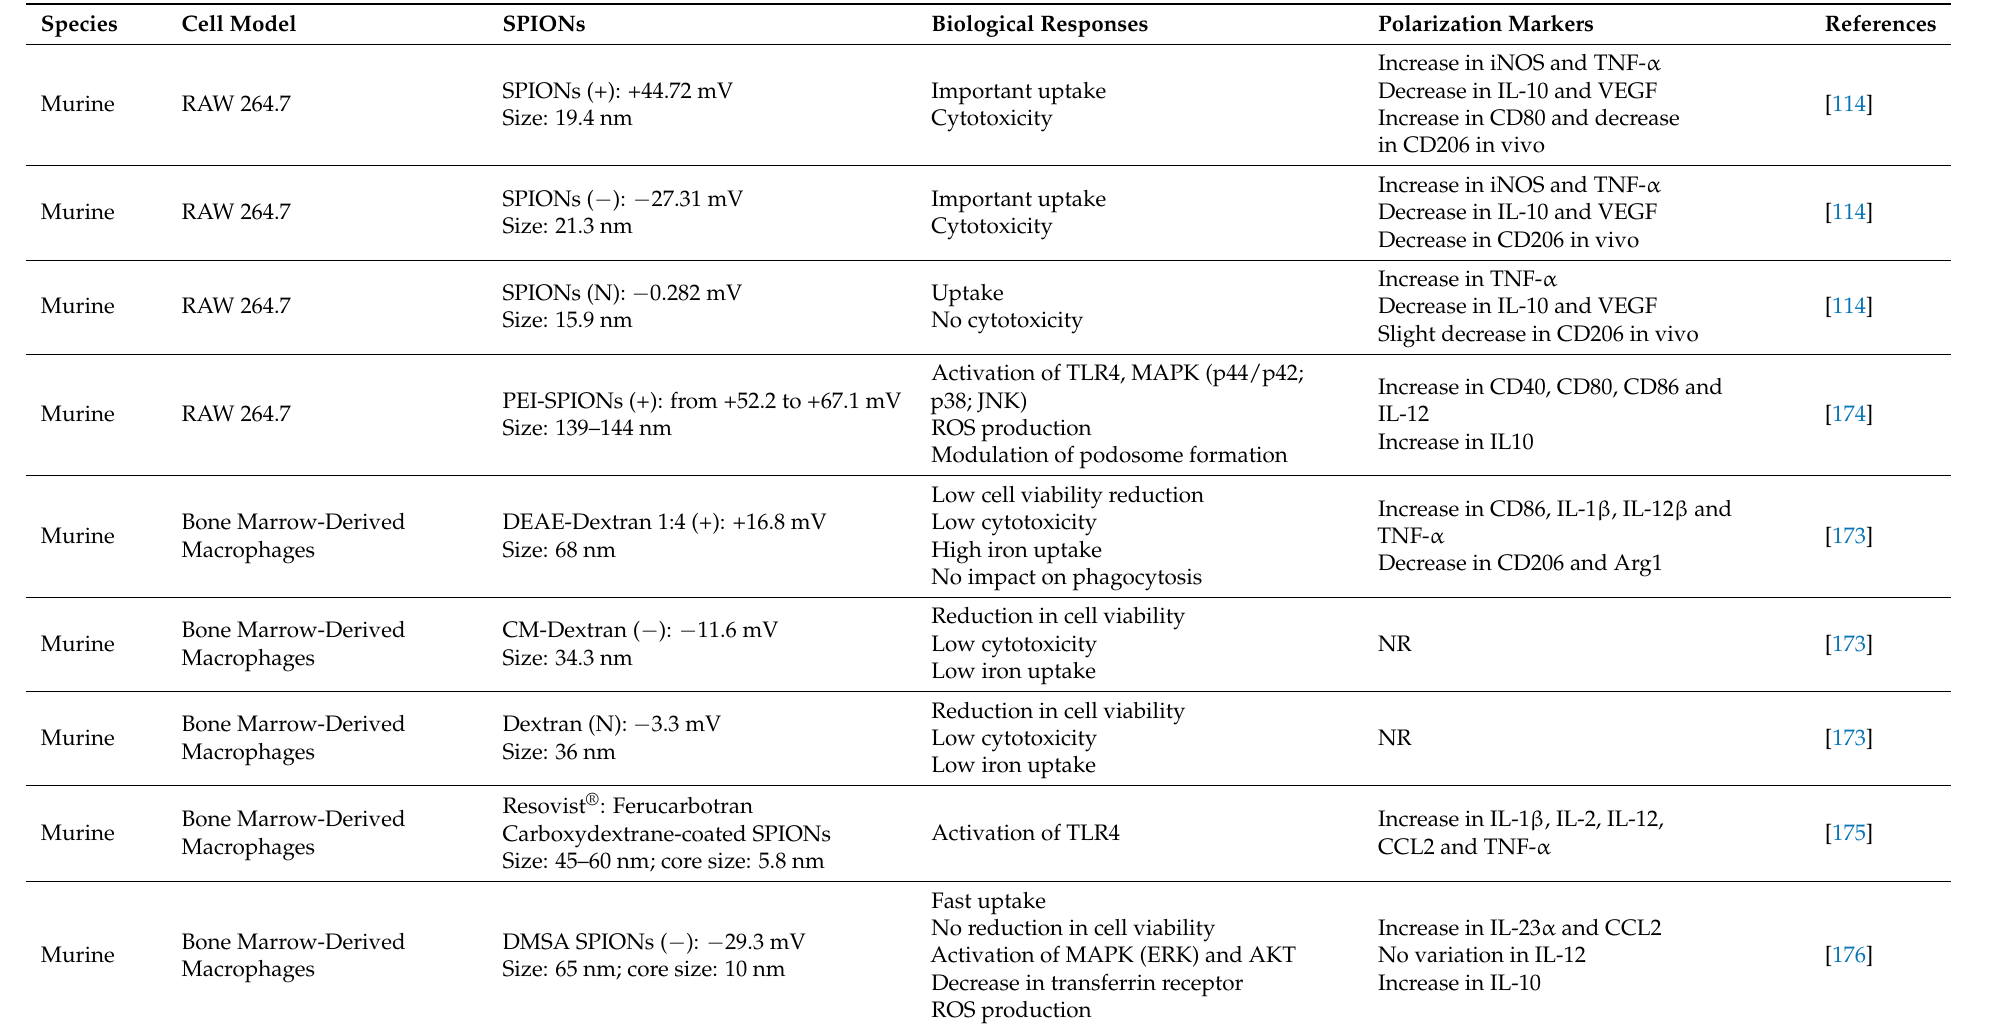
Table 3. Impact of SPION treatment on monocytes and